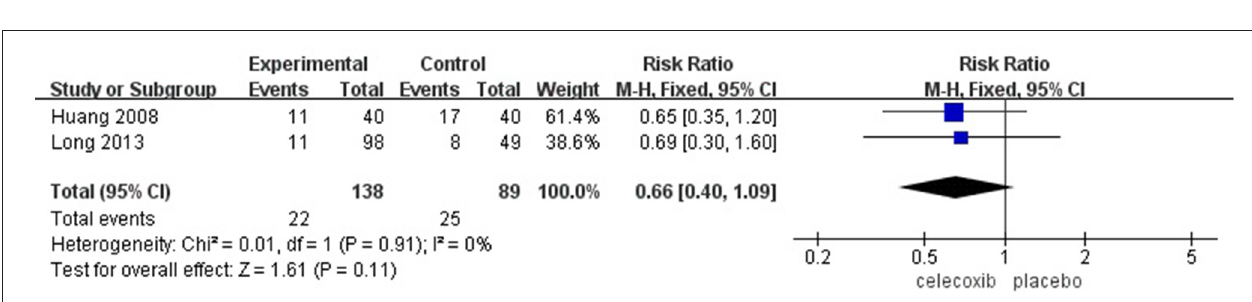
FIGURE 6 | Meta-analysis of the incidence of